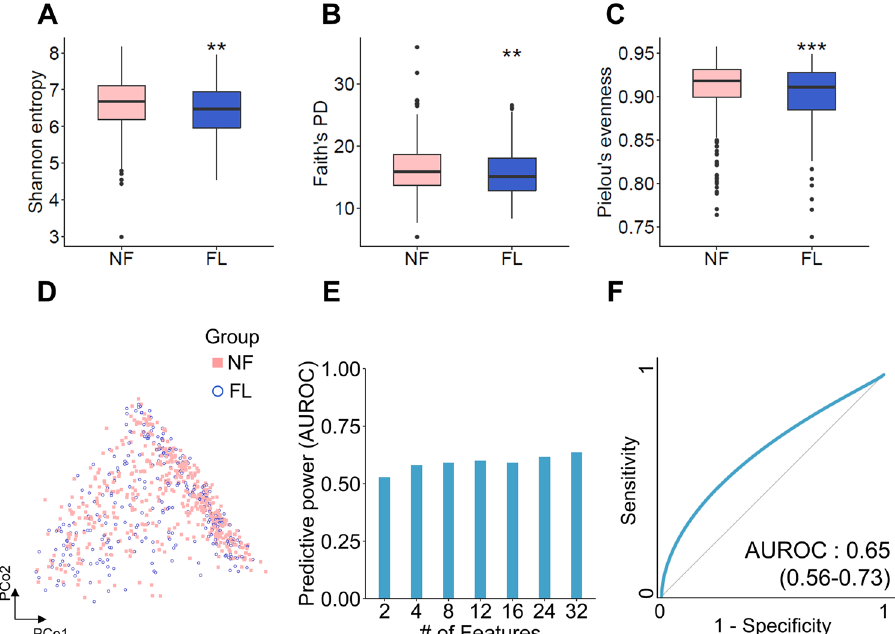
Figure 2. Comparison of the alpha and beta diversity of gut microbiome between fatty liver disease (FL) and nonfatty liver control (NF) groups. ( A – C ) Alpha diversity of NF and FL was measured using Shannon’s entropy ( A ), Faith’s phylogenetic diversity (PD) ( B ), and Pielou’s evenness ( C ). Boxes represent the IQR, whereas the upper whiskers represent the range from minimum (upper quartile − 1.5IQR) to maximum (lower quartile + 1.5IQR), and black dots represent outliers excluded in the range. (D) Beta diversity among participants in NF and FL was measured using the Principal Coordinates Analysis (PCoA). (E–F) The predictive power (AUROC) of the RF prediction model featuring different discriminative gut microbial genera in the training dataset (E) and test dataset (F). Statistical significance was analyzed using the Kruskal–Wallis test. * p < 0.05, ** p < 0.01. FL: participants with fatty liver disease; IQR: interquartile range; ML: machine learning; NF: nonfatty liver control group; RF: random